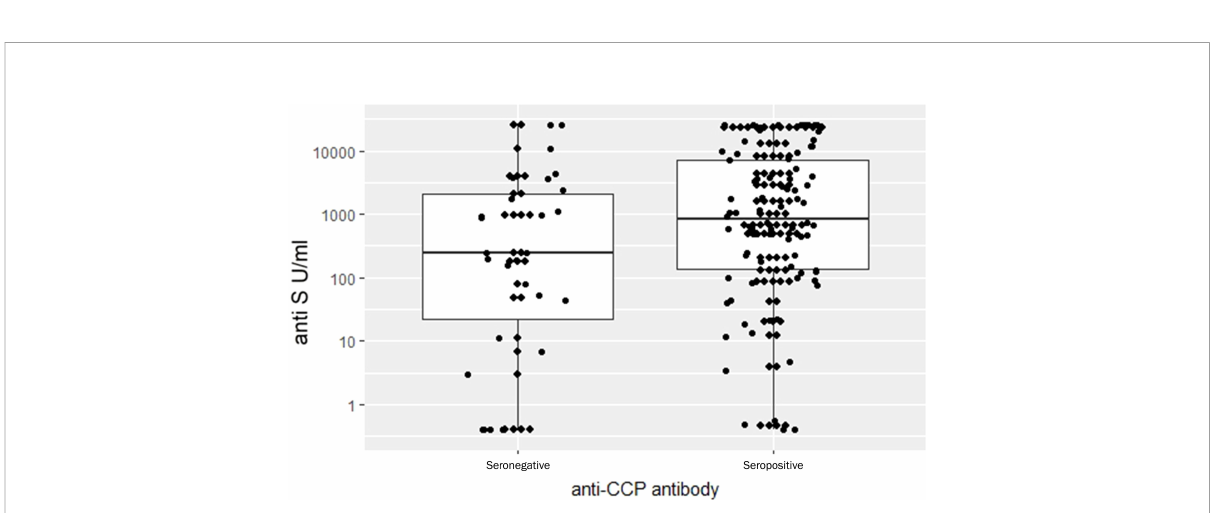
FIGURE 6 Comparison anti-S Ig levels between RA anti-CCP seronegative and seropositive patients. Observed data. Detailed statistical analysis showed that the difference between the groups is highly signi fi cant (p=